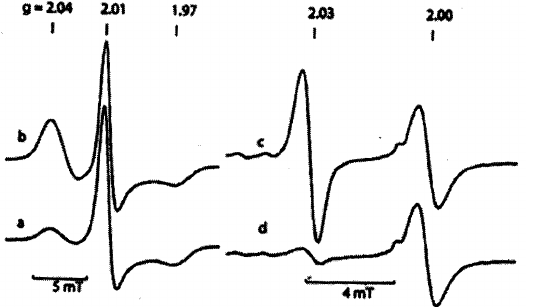
Figure 21. The EPR spectra of B-DNIC with glutathione recorded in the presence of sodium dithio- nite at pH 10.7 (curves ( b , c )) and 7.2 (curves ( a , d )) at 77K (curves ( a , b )) or at ambient temperatures (curves ( c , d )) [99]. (With permission)